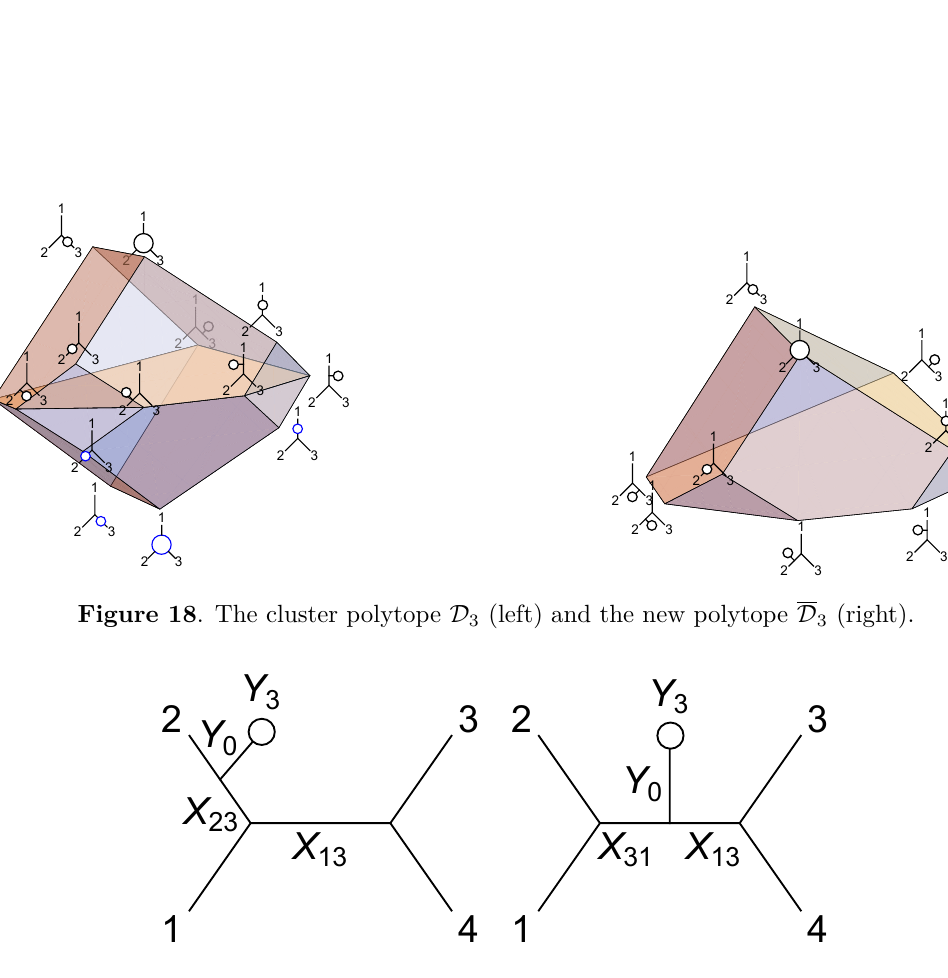
Figure 19 . Tadpole diagrams and the associated